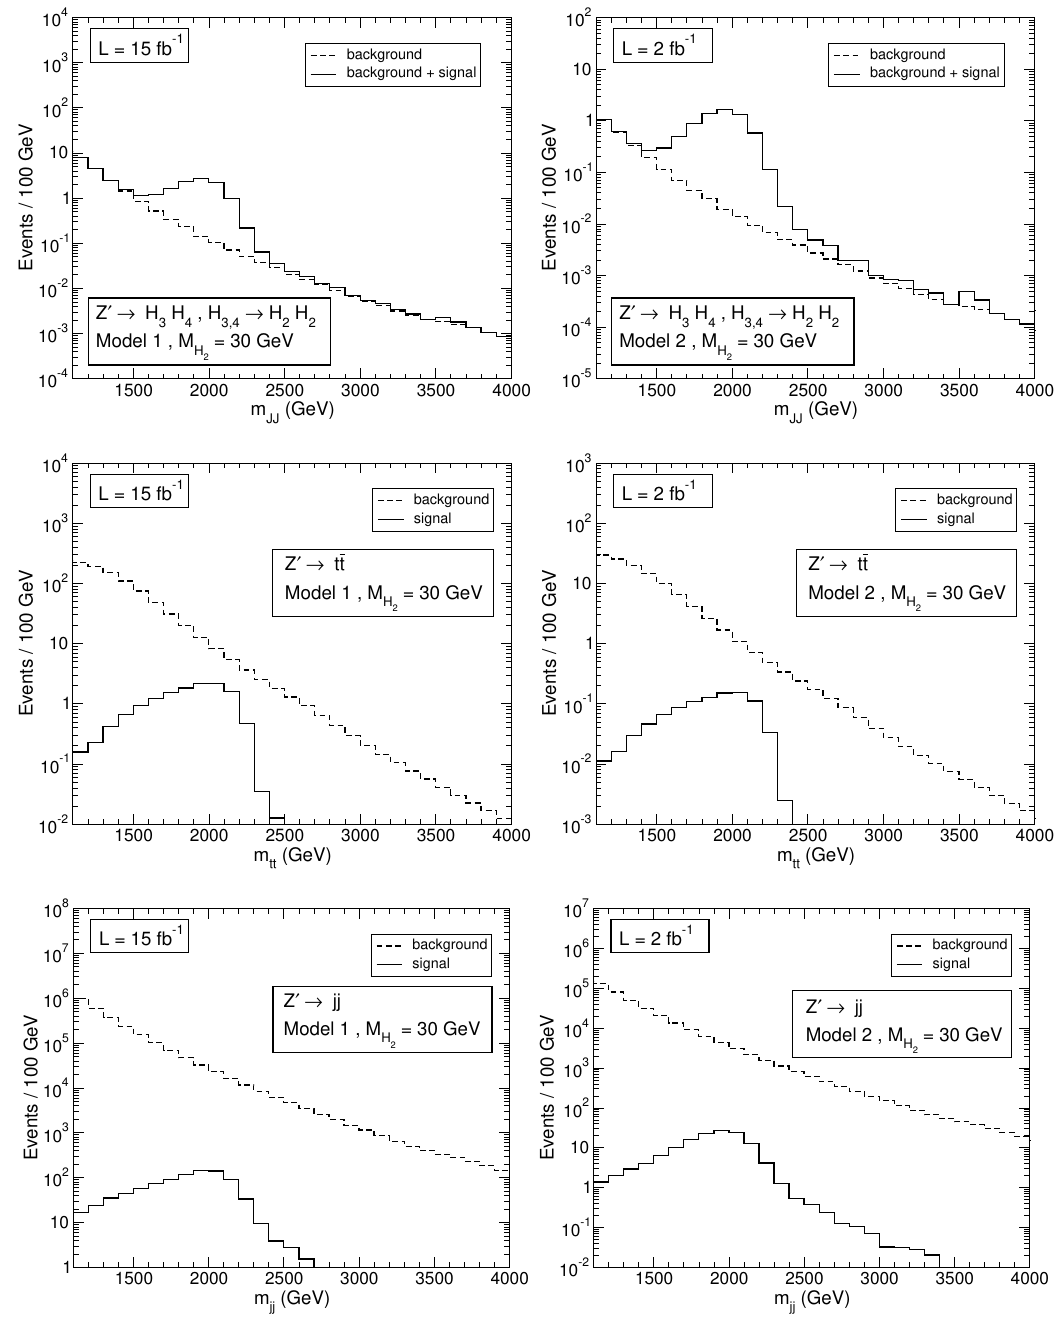
Figure 4 . Invariant mass distribution for the Z 0 signals in scenario 1 and their backgrounds, in the stealth boson (top), t (cid:22) t (middle) and dijet (bottom) analyses, for model 1 (left) and model 2